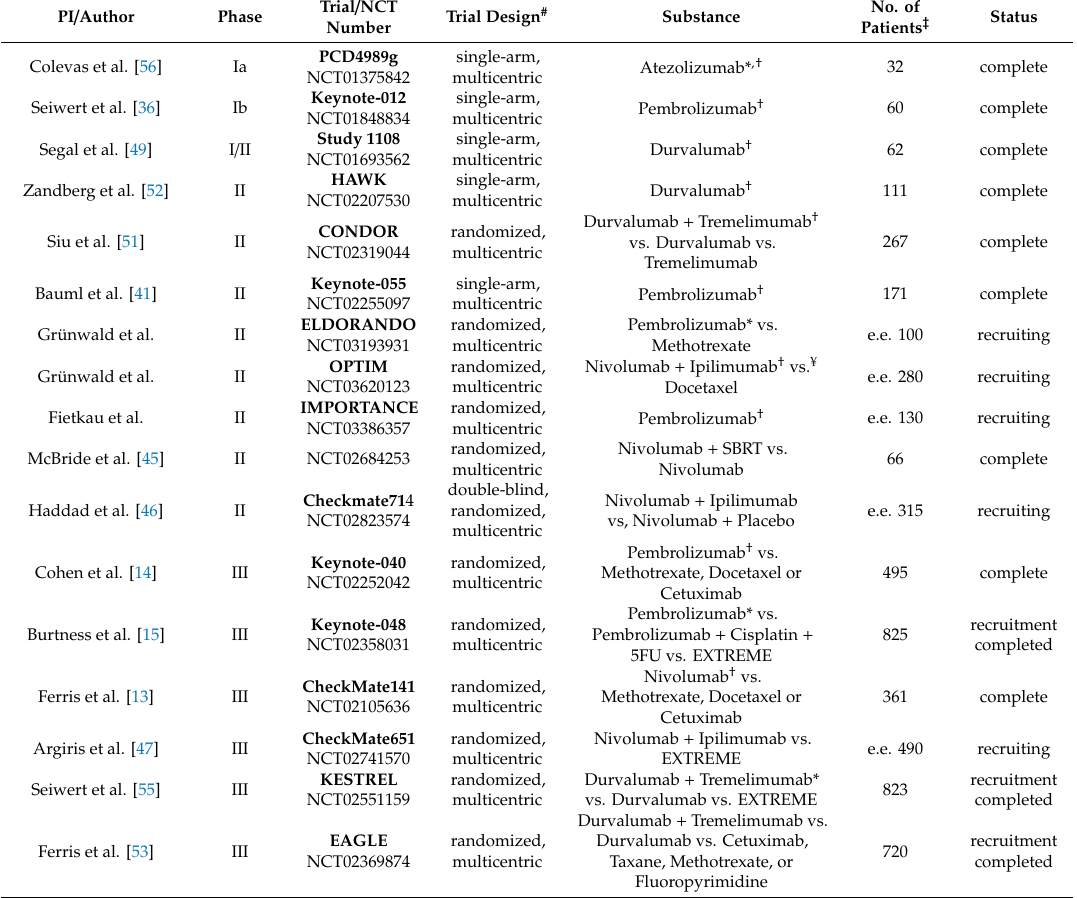
Table 1. Selected trials including immune-checkpoint inhibition for recurrent / metastatic SCCHN.